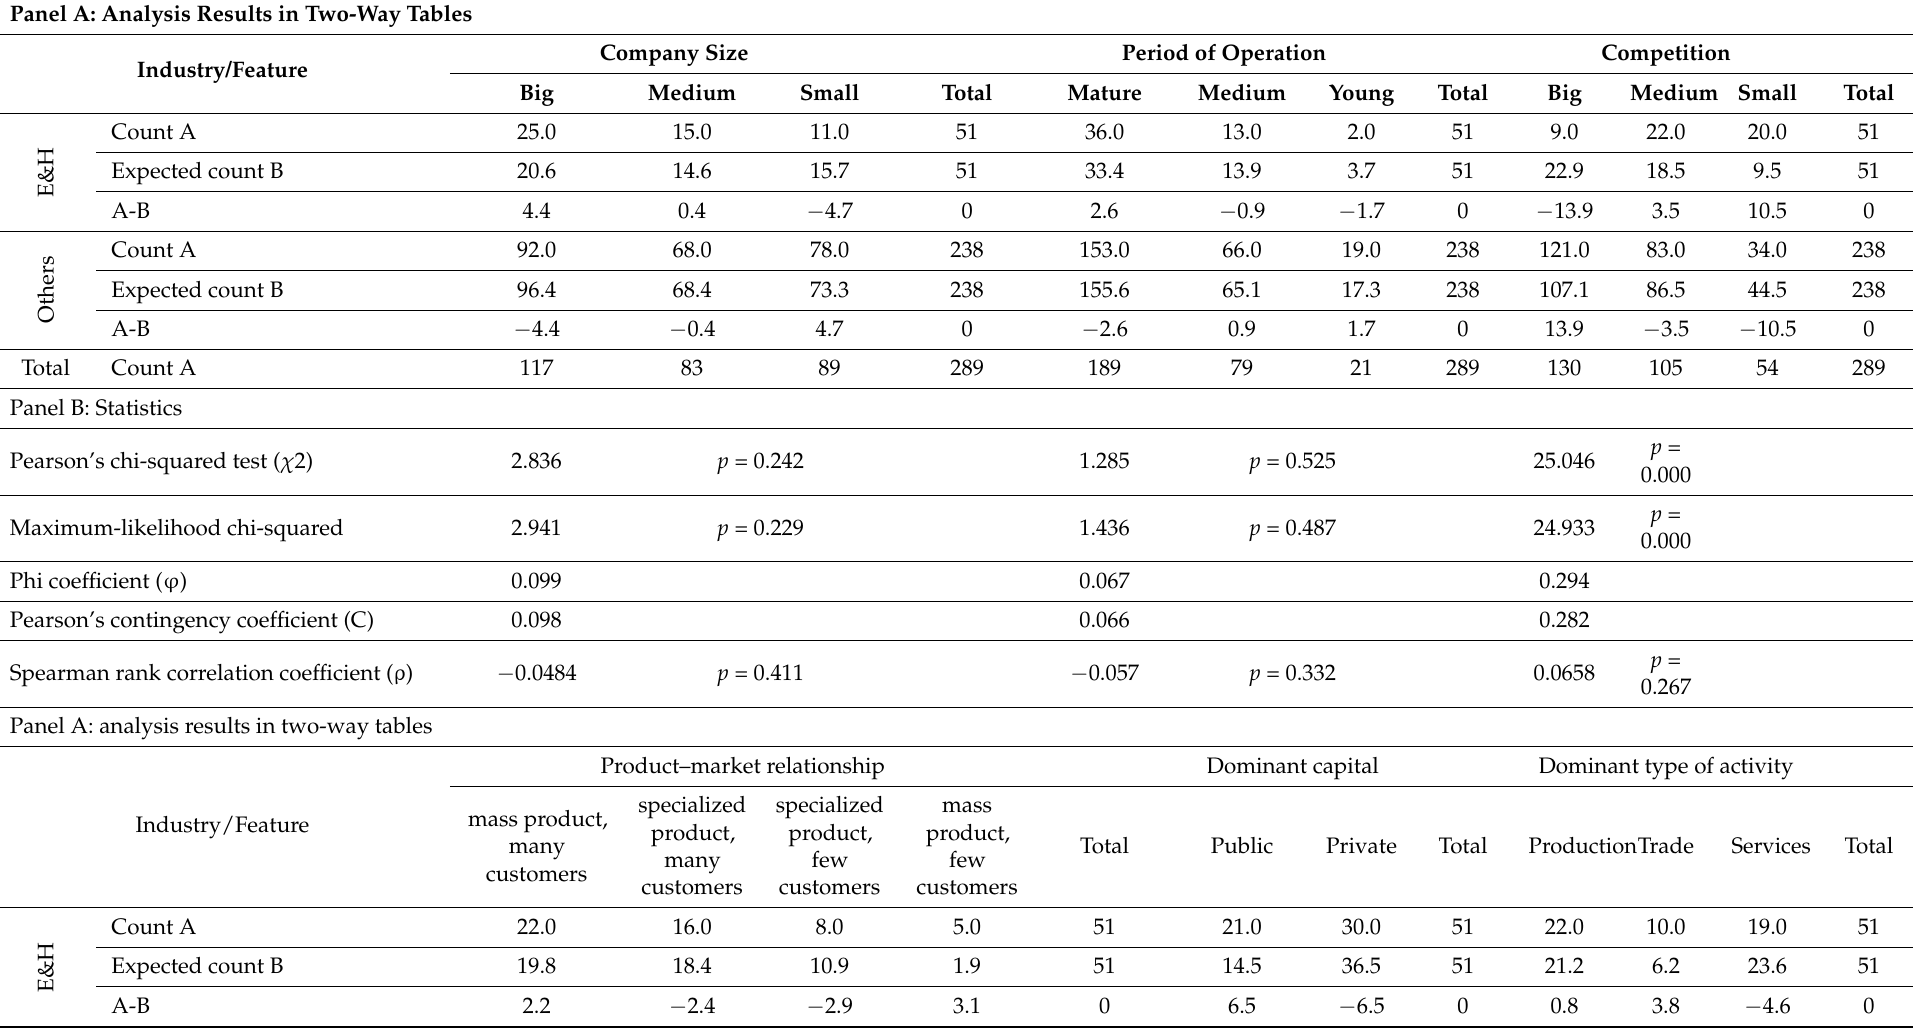
Table 2. Features of the research